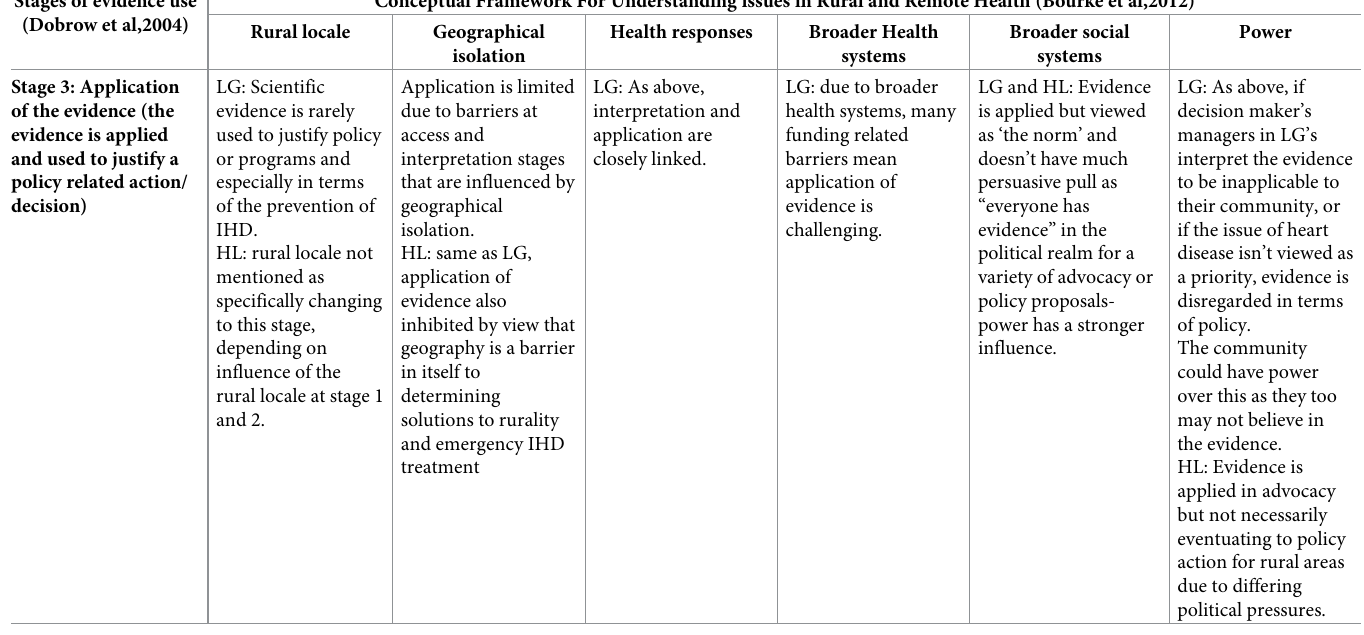
their policy work was